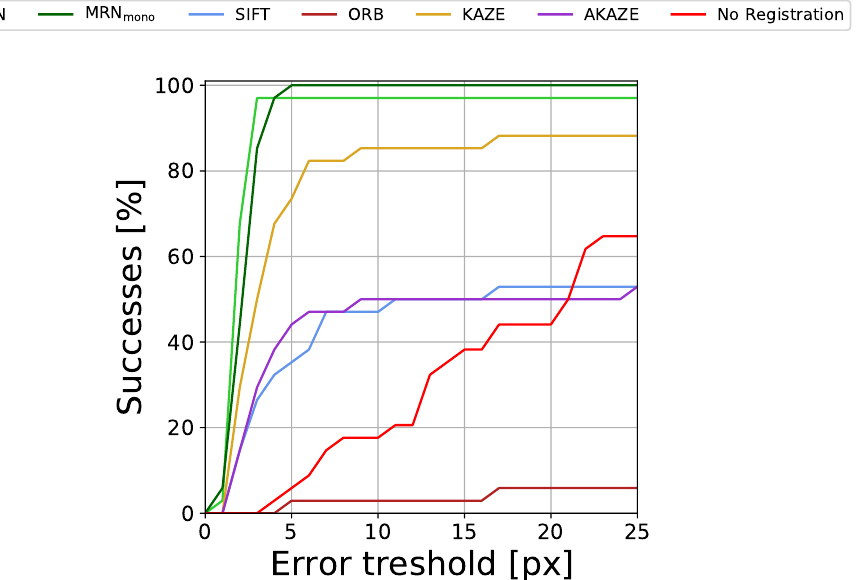
Figure 7. Percentage of successfully registered images for different registration error (RE)